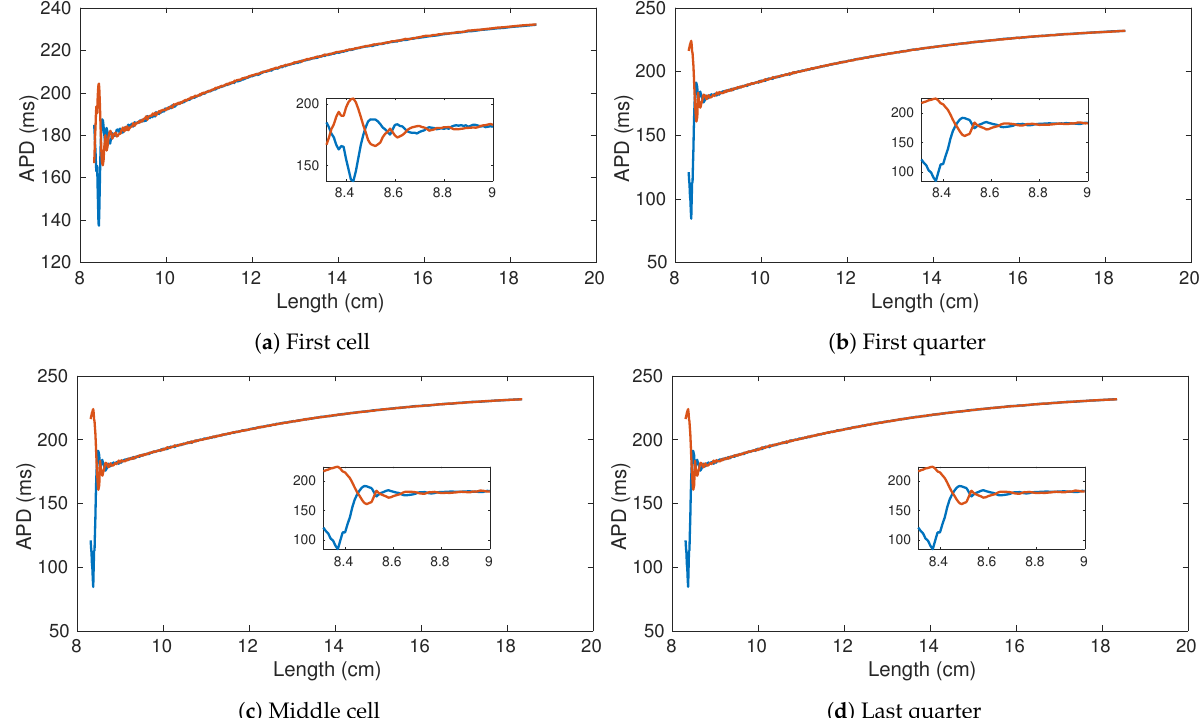
Figure 9. APD bifurication diagrams of two rings with 1750 cells (17.5 cm) and different von Mises distributions: ( a ) µ = 1.55, κ = 8; ( b ) µ = 1.98, κ = 10.